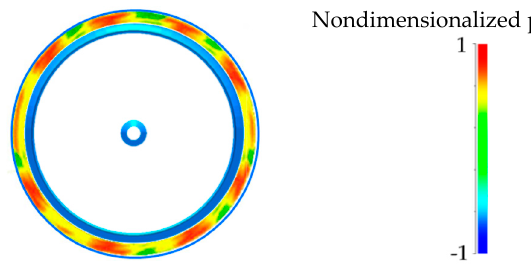
Figure 17. Time-averaged pressure distribution on the WLT Ci05 brim.